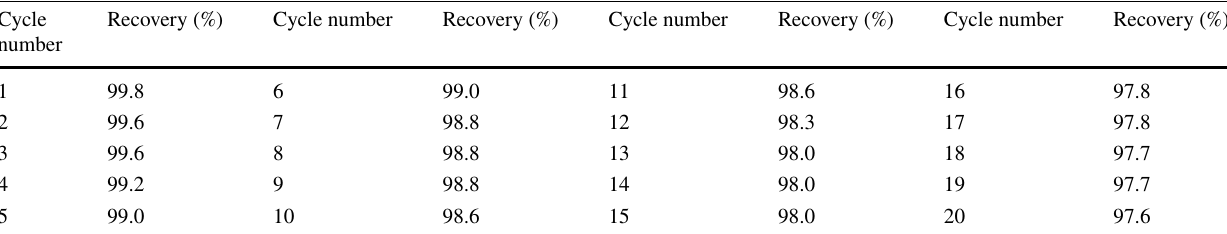
Table 8 Recovery of Fe(III) ions from various samples after its separation on Fe(III)-ion imprinting polymer (100 mL of sample: pH 2.5, mean value, n = 3)